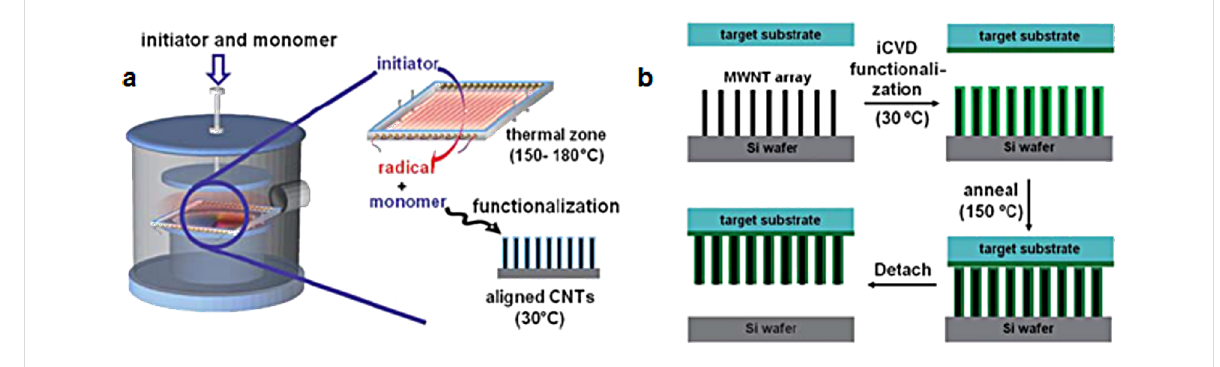
Figure 20: (a) Schematic illustration of the iCVD functionalization process of aligned CNTs and (b) schematic of the MWCNT transfer process. Adapted with permission from [156]. Copyright 2011 Royal Society of Chemistry.